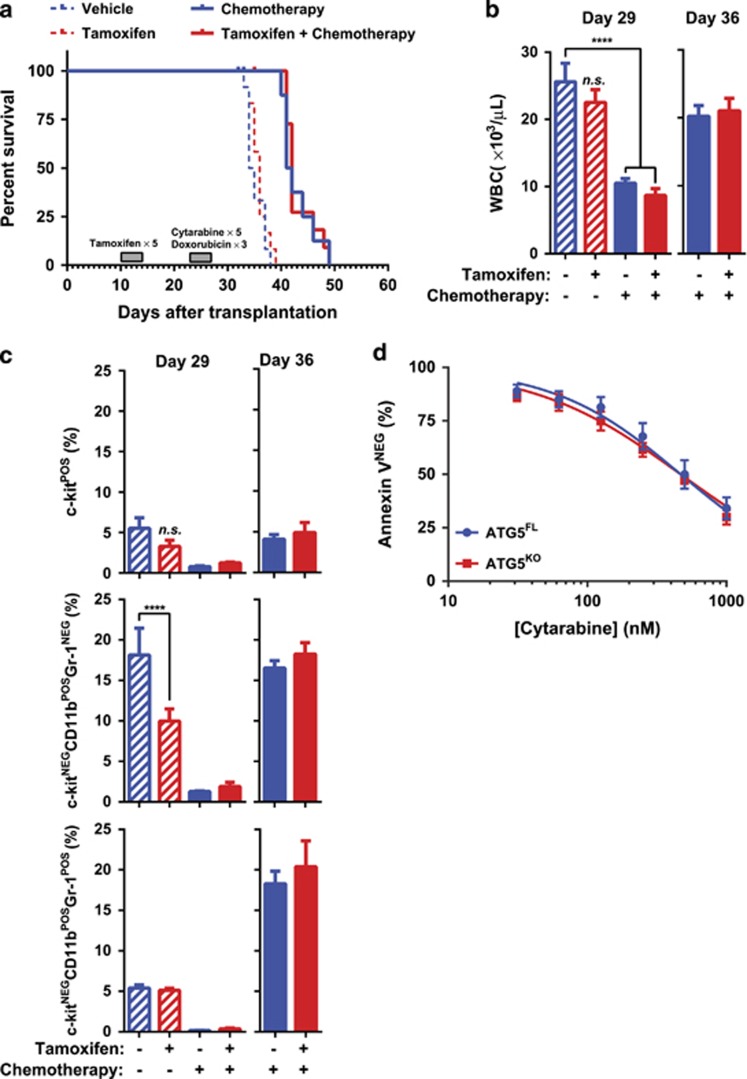
The role of Atg5 in progression and chemotherapy response of MLL-AF9-driven murine AML. (a) The Kaplan–Meier survival curve of non-irradiated C57BL/6J recipient mice transplanted with malignant Atg5FL AML cells. Gray boxes indicate the dates by which the indicated treatments or vehicle controls were given once daily. (b) WBC counts as enumerated by peripheral blood flow cytometry of mice from panel (a) at the indicated dates. Error bars represent the S.E.M. of 10 mice. Statistics were calculated by ANOVA with multiple comparisons. ****P<0.0001; NS, not statistically significant. (c) Peripheral blood flow cytometric analysis of mice from panel (a) on the indicated days shows the Annexin V−7-AAD− cells of the indicated phenotype as a percentage of total Annexin V−7-AAD−CD45+ cells. Error bars represent S.E.M. of 10 mice. Statistics were calculated by ANOVA with multiple comparisons. ****P<0.0001; NS, not statistically significant. (d) Atg5FL or Atg5KO cells were treated with the indicated concentrations of cytarabine for 24 h and subjected to flow cytometric analysis, representing Annexin V− cells as a percentage of all cells and normalized to untreated controls. Error bars indicate S.D. of five different clones